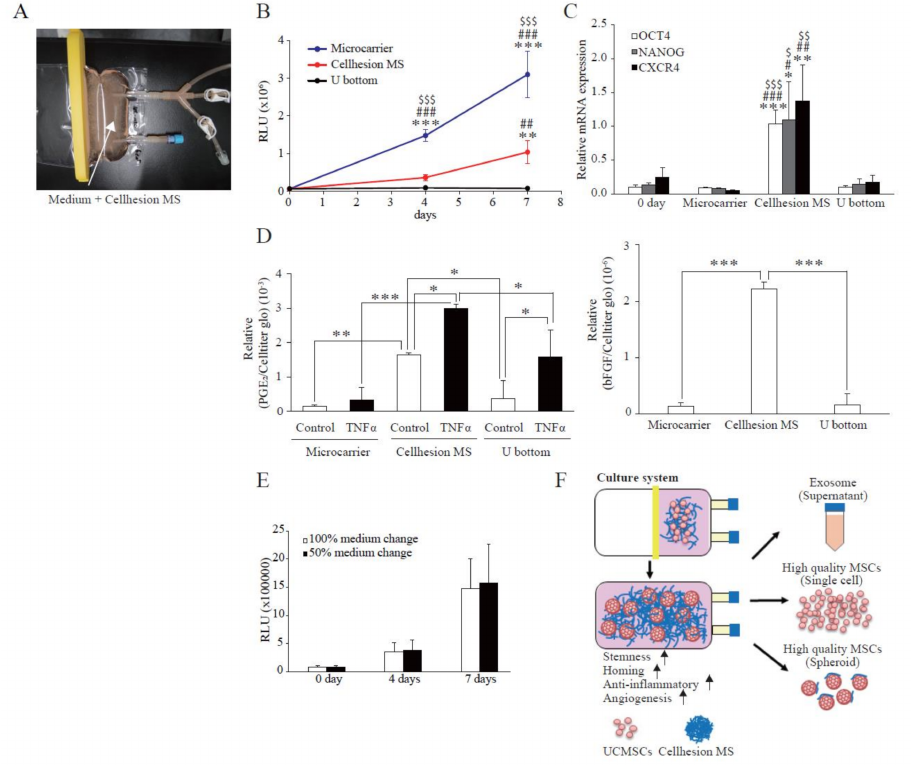
Figure 5. Scaled-up culture of UCMSCs using a culture bag to produce a closed culture system. ( A ) An image of the culture bag configuration. White arrows indicate medium containing 0.05% Cellhesion ® MS. ( B ) Comparison of cell growth in each culture method. The number of